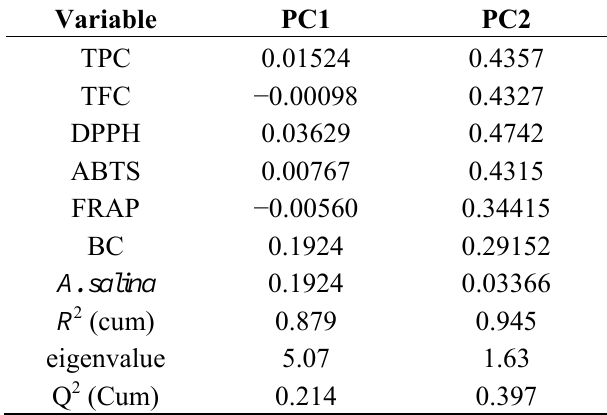
Table 3. Loadings, eigenvalues and percentage of cumulative variance for the first three principal components of the data from the Helichrysum samples.